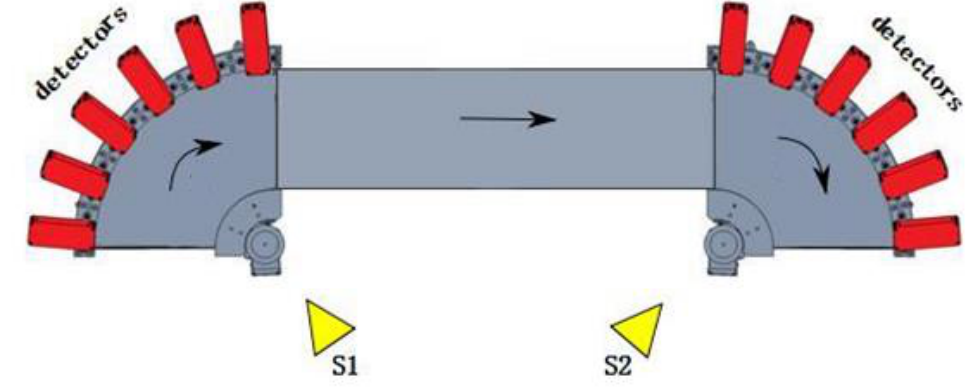
Figure 1. 2D top view of the ObT system showing the main components: the x-ray sources (yellow triangles), the strip detectors (red boxes), and the conveyor belts (grey